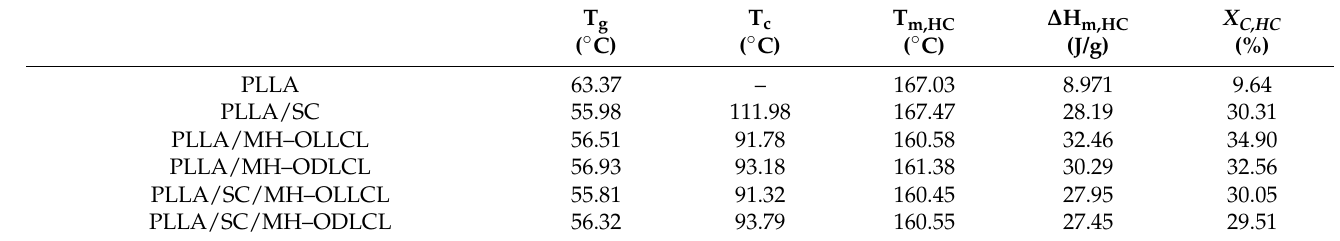
Figure 4. Characterization of the PLLA composites. ( A ) SEM image, ( B ) ATR–FTIR spectra, ( C ) TGA thermograms, ( D ) XRD spectra, and ( E ) DSC thermograms of the PLLA, PLLA/SC, PLLA/MH–OLLCL, PLLA/MH–ODLCL, PLLA/SC/MH–OLLCL, and PLLA/SC/MH–ODLCL composites. Table 2. Thermal properties of the PLLA, PLLA/SC, PLLA/MH–OLLCL, PLLA/MH–ODLCL, PLLA/SC/MH–OLLCL, and PLLA/SC/MH–ODLCL